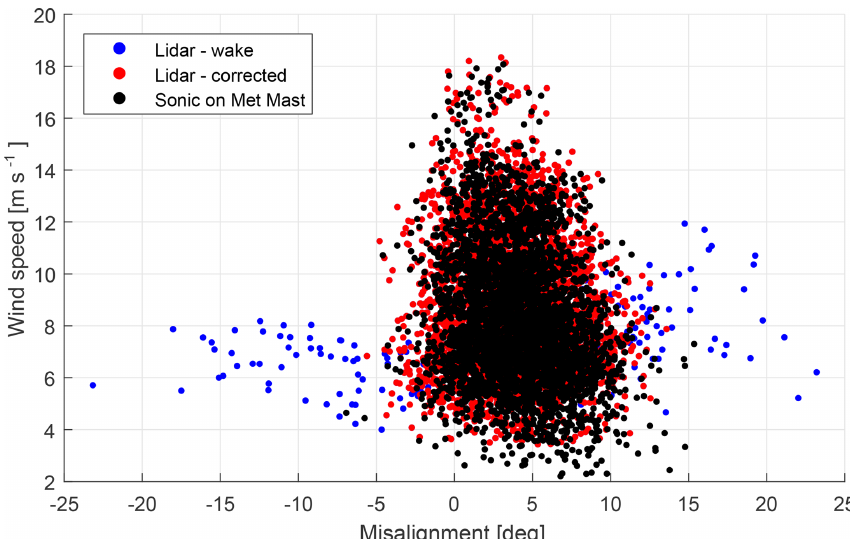
Figure 13. Comparison between the 10min mean yaw misalignment estimated from the lidar and the sonic on the meteorological mast (Met Mast). The observations affected by wakes are shown in blue and the corrected measurements in